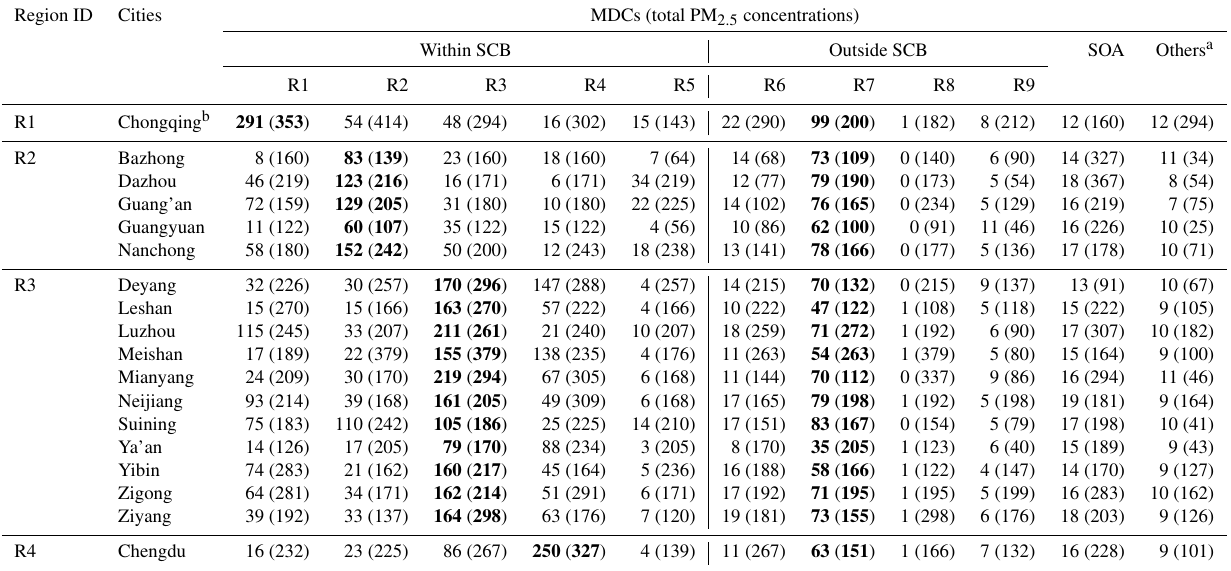
Figure 3. (a) Spatial distributions of predicted PM 2 . 5 concentrations (µgm − 3 ) and (b–l) the source-region contributions to PM 2 . 5 (%) in the summer. Others includes IC, BC, windblown dust, and sea salt. Table 3. Predicted maximum daily contribution from a given region (MDCs) in the SCB city center and the corresponding PM 2 . 5 concentra- tions in the city center on the same day. Only winter data are included in this table. The units are µgm − 3 . The numbers in the bold present the contributions due to local emissions or that from